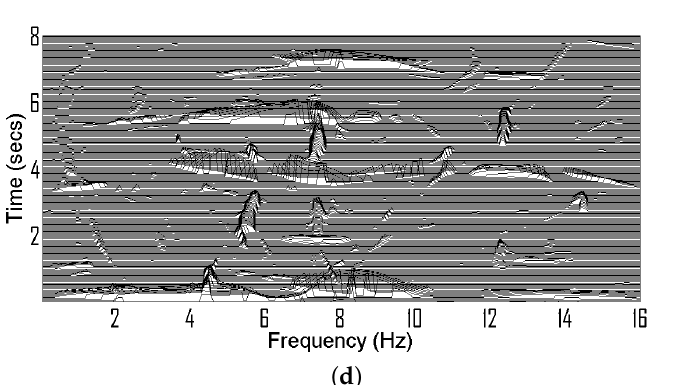
Figure 4. ( a ) TF signature of EEG seizure signal composed of summation of spikes and low frequency component, ( b ) Extracted TF signature of seizure signal obtained by ρ